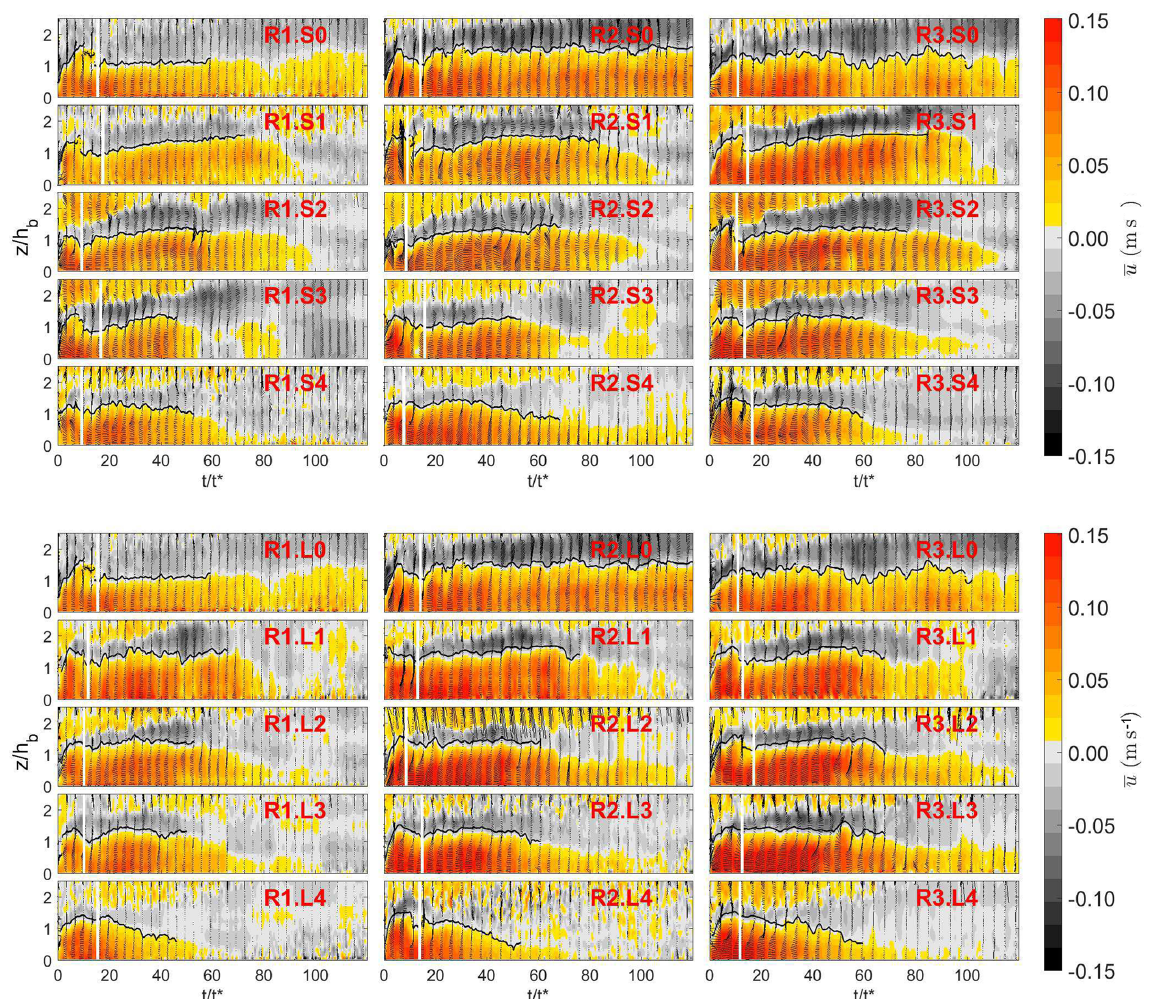
Figure 5. Streamwise velocity field on the background and velocity vectors of the components ( u , w ). The head of the current is delimited by the vertical white line. The contour of the current is indicated in